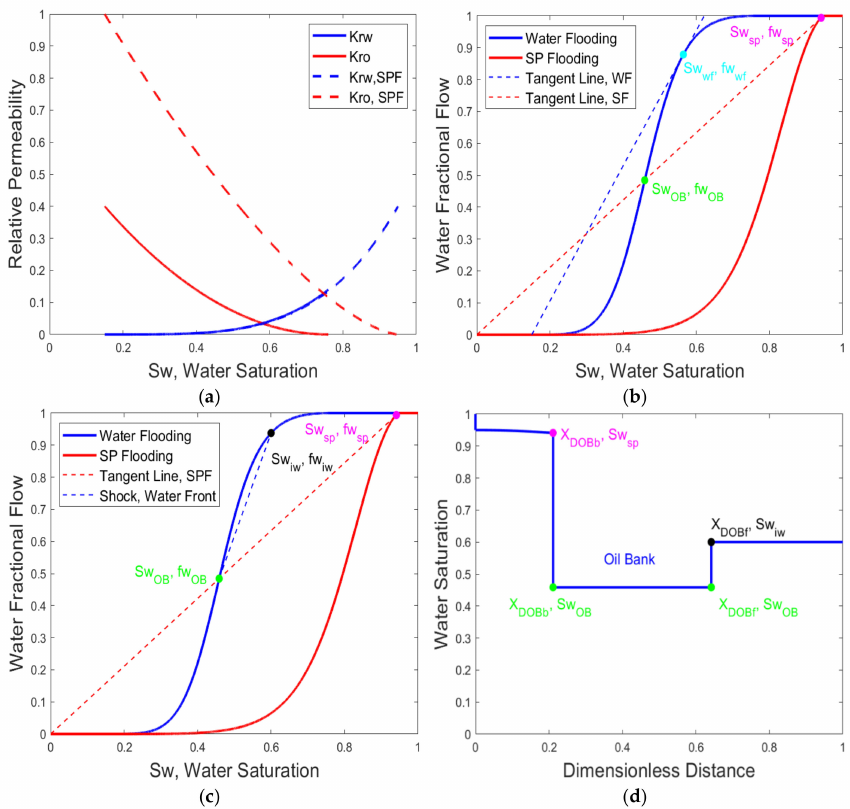
Figure 22. ( a ) Water–oil two-phase relative permeability for water flooding and surfactant / polymer (SP) flooding; ( b ) Construction of shock front for water flooding and SP flooding; ( c ) Construction of shock front for continuous tertiary SP flooding, no adsorption; and ( d ) Water saturation profile at t D = 0.20 PV during SP flooding, no adsorption.